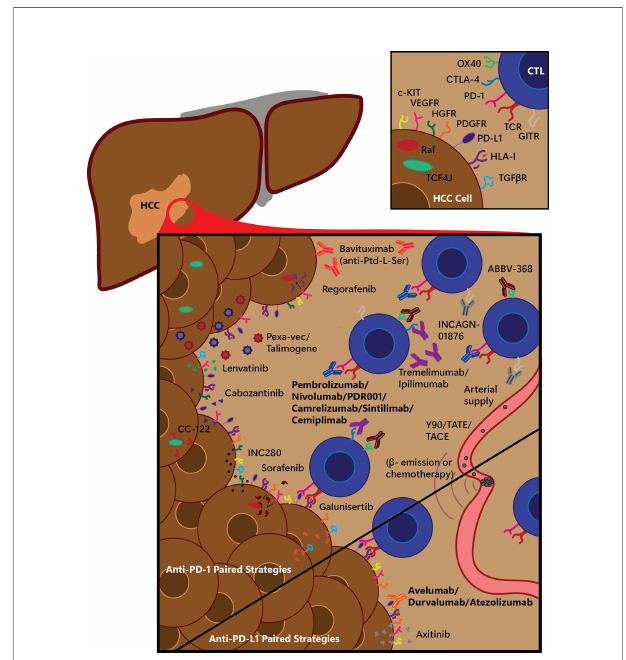
FIGURE 1 | Selected experimental immunotherapy treatment combination strategies for anti-PD-1 and anti-PD-L1 therapy. Many small molecule drugs and other treatments are being tested in combination with standard immune checkpoint blockade (ICB) immunotherapeutics; a graphical overview of a selection of these are shown here, being tested with anti-PD-1 or anti-PD-L1 therapies. Main fi gure depicts various treatment strategies on a hepatocellular carcinoma (HCC) tumor, in fi ltrating cytotoxic T-lymphocytes (CTLs), and arterial-derived tumor-speci fi c vasculature, divided into treatments being tested along with anti-PD-1 therapy (top, tested with either Pembrolizumab, Nivolumab, or PDR001) or with anti-PD-L1 therapy (bottom, tested with Avelumab, Durvalumab or Atezolizumab). b -, electron emission radiation; CTL, cytotoxic T-lymphocyte; CTLA-4, cytotoxic-T-lymphocyte-associated protein 4; HCC, hepatocellular carcinoma; HGFR, hepatocyte growth factor receptor; HLA-I, human leukocyte antigen class I; GITR, glucocorticoid-induced tumor necrosis factor receptor related; PD-1, programmed cell death protein 1; PD- L1, programmed cell death protein ligand 1; PDGFR, platelet-derived growth factor receptor; Pexa-Vec, pexastimogene devacirepvec; Ptd-L-Ser, phosphatidylserine; TACE, trans-arterial chemoembolization; TATE, trans- arterial tirapazamine embolization; TCF4J, transcription factor 4 J isoform; TCR, T-cell receptor; TGF b R, transforming growth factor b receptor; VEGFR, vascular endothelial growth factor receptor; Y90, yttrium-90